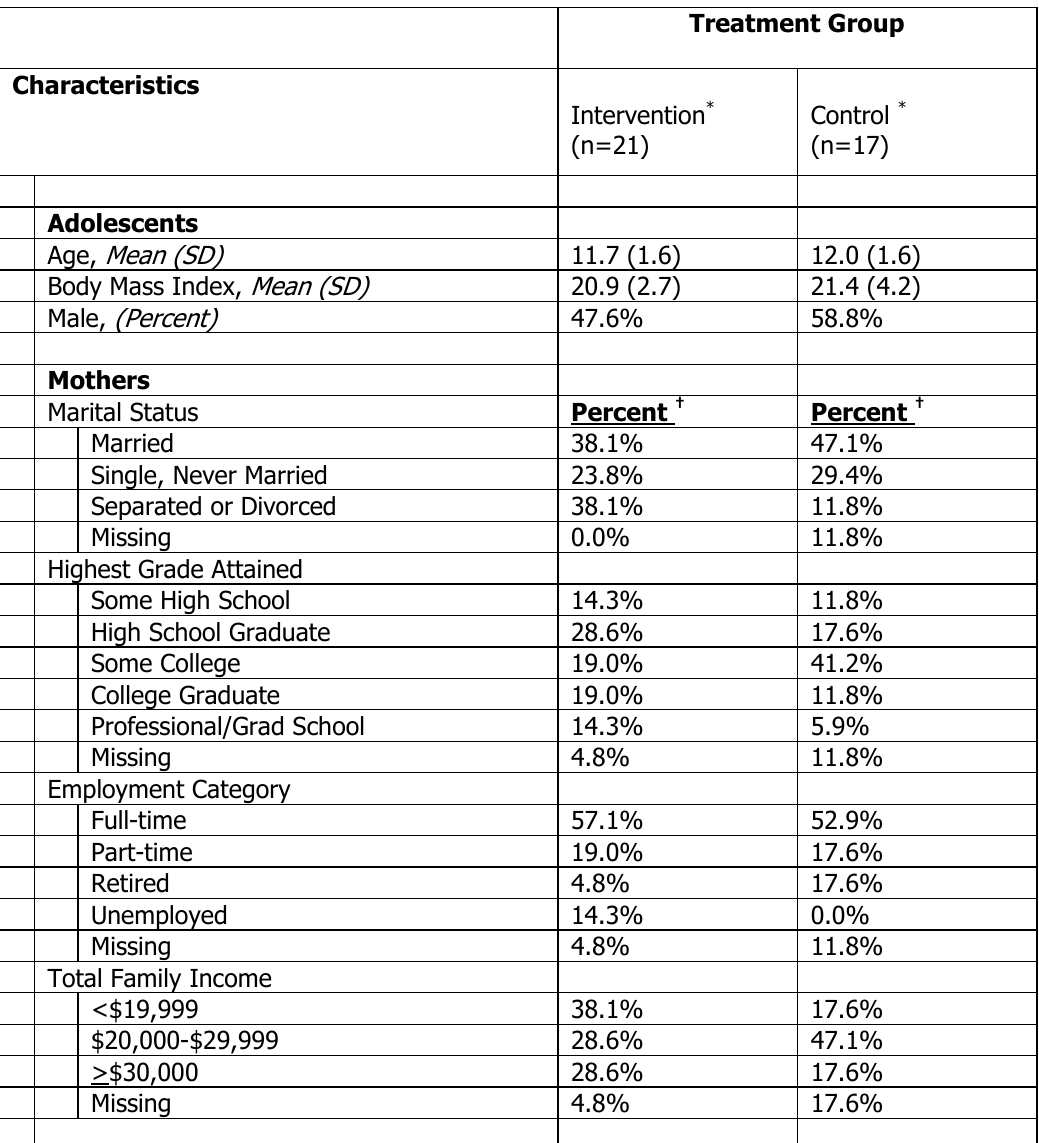
Study participant characteristics by participant treatment group